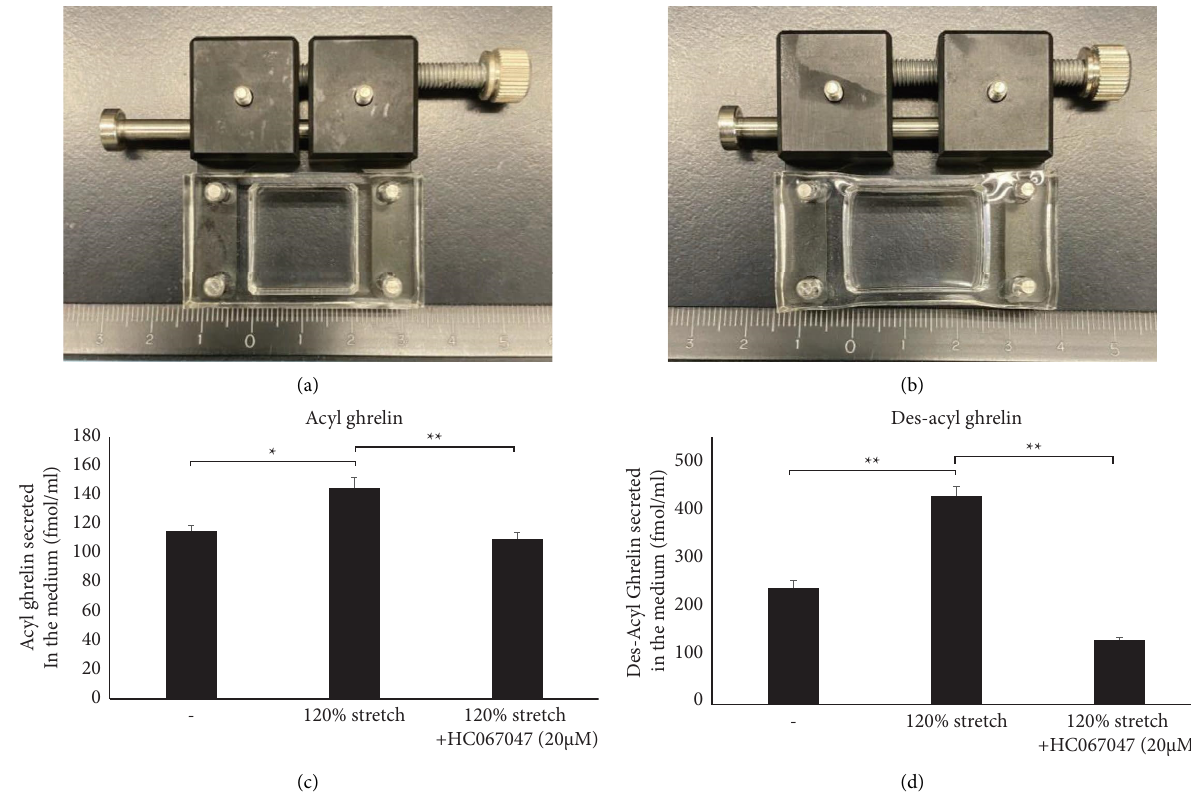
Figure 6: Regulation of ghrelin secretion by mechanical stimuli in MGN3-1 cells (ELISA). Cells were subjected to a 120% stretch nine times for 3min twice. Tis stretch protocol was repeated 2 hours later. After 4 hours, acyl ghrelin and des-acyl ghrelin were measured by the ELISA. (a) Unstretched MGN3-1 cells. (b) 120% stretch of MGN3-1 cells. (c) Te amount of acyl ghrelin in the supernatant obtained after 120% stretch and treatment of MGN3-1 cells with HC067047 (20 μ M) +120% stretch. (d) Te amount of des-acyl ghrelin in the supernatant obtained after 120% stretch and treatment of MGN3-1 cells with HC067047 (20 μ M) +120% stretch. ( ∗ p < 0 . 05; ∗∗ p < 0 . 001; n � 5; error bar: standard error of the